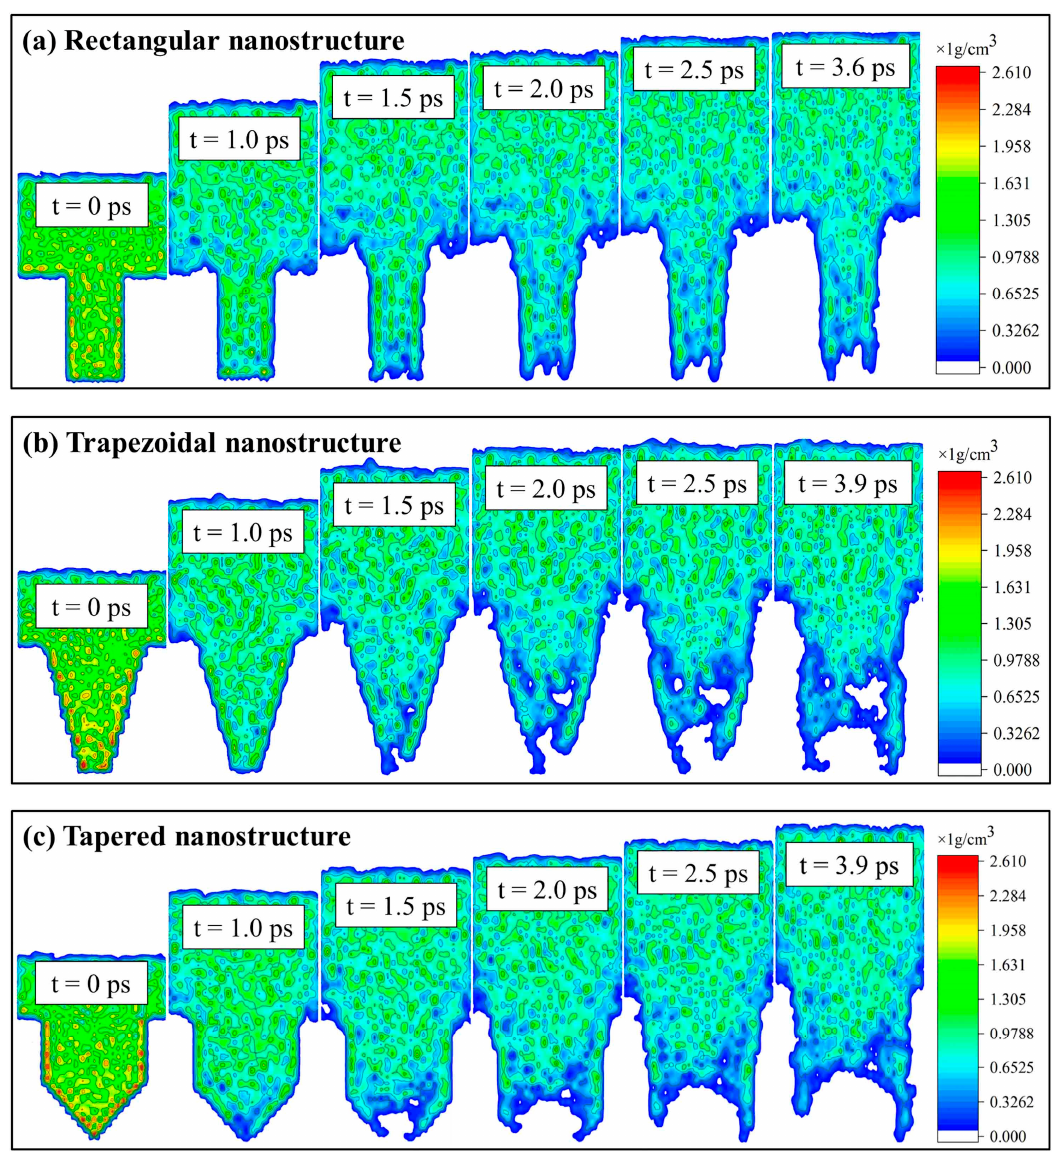
Figure 5. Density distributions of the demolding process of PP nanostructures with different shapes: ( a ) Rectangular nanostructure, ( b ) trapezoidal nanostructure, ( c ) tapered nanostructure.